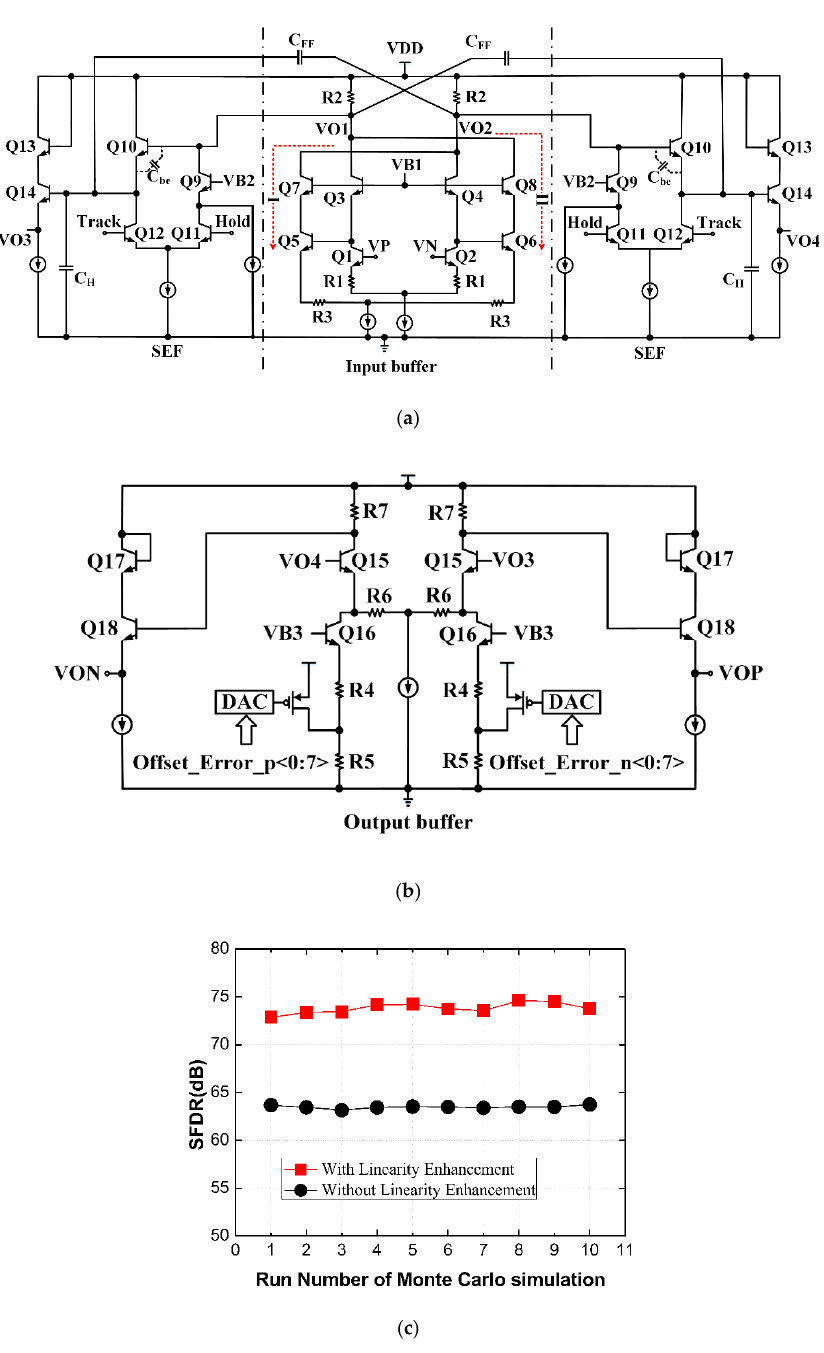
Figure 3. ( a ) Input buffer and switched emitter follower (SEF) in the track-and-hold amplifier (THA); ( b ) Output buffer with offset calibration interface; ( c ) Comparison of linearity enhancement effect.